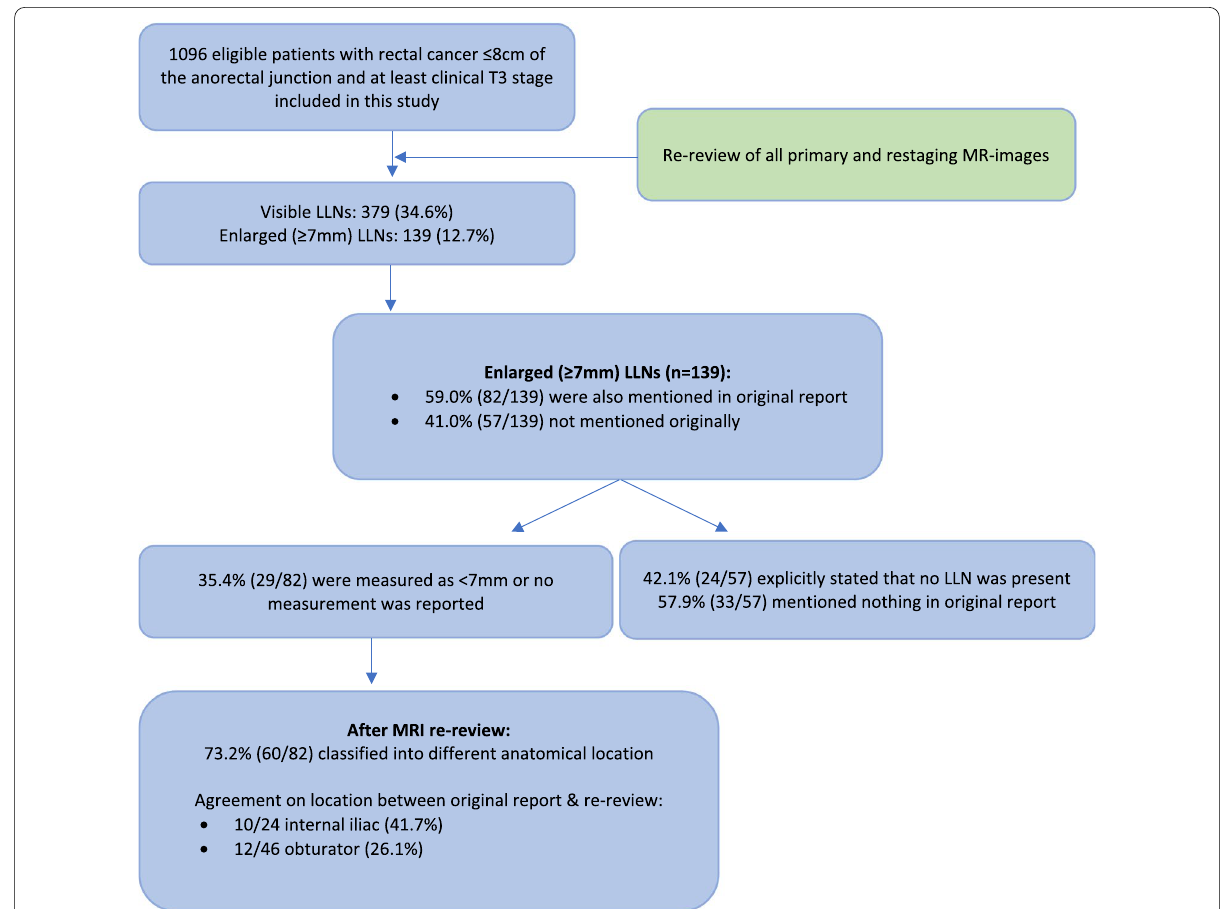
Fig. 5 Flowchart of results for enlarged LLNs according to MRI